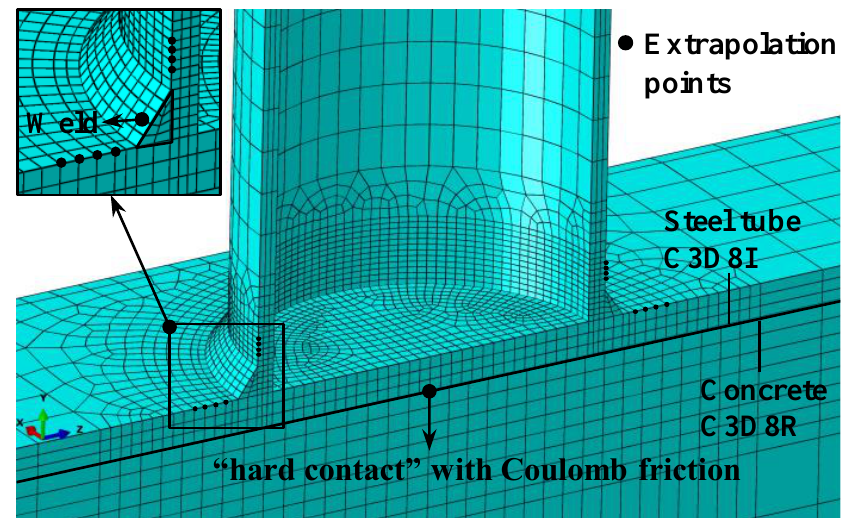
Figure 6: Finite-element grids of a CHS-CFSHS T-joint (partial).